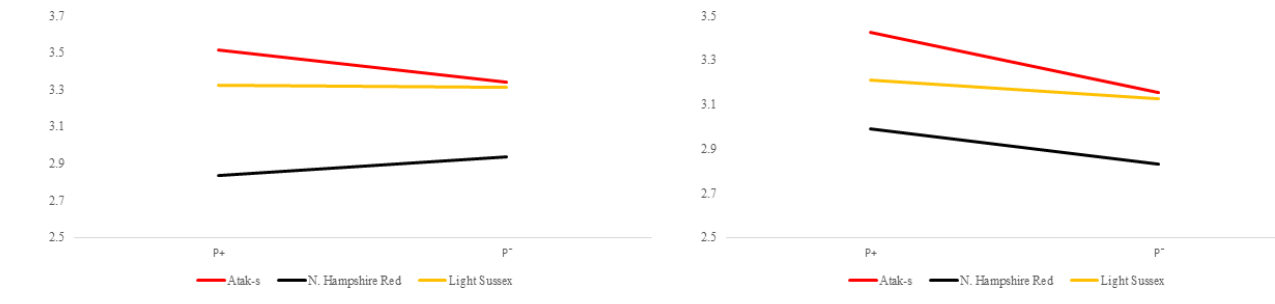
Figure 6. Averages of feed conversion ratio for infested (P + ) and non-infested (P − ) groups in feed-restricted conditions (FR); feed g /